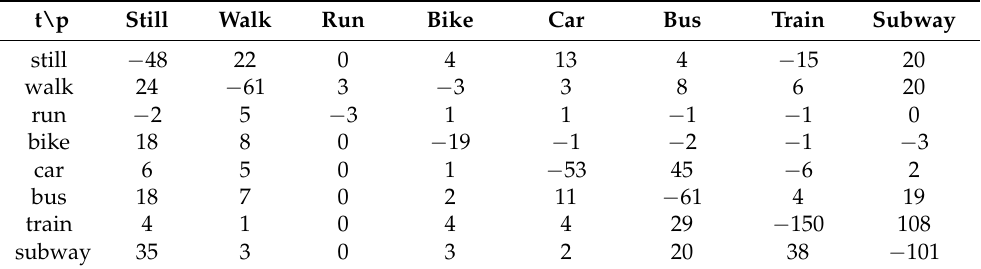
Figure 15. The 2D encoded representation of the last activations of the LSTM layer for the pressure sensor. Color codes: blue (still), orange (walk), green (run), red (bike), violet (car), brown, (bus), pink (train), grey (subway). Table 9. The difference confusion matrix of the network trained without the orientation software sensor. The largest loss in classification occurred in the class subway and the smallest in class run . t = true label, p = predicted label.